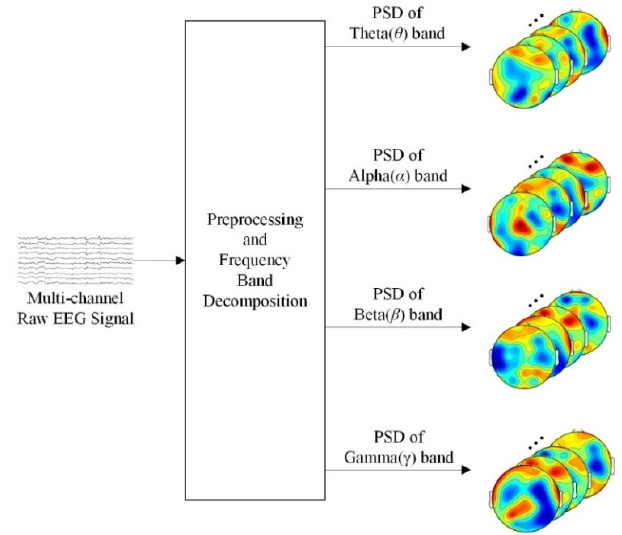
Figure 3. 3D cuboid representation of the entire multi-channel EEG in each frequency band. PSD distributions of multiple EEG electrodes constitute a topographic map. The PSD variation of EEG electrodes over time forms depth.